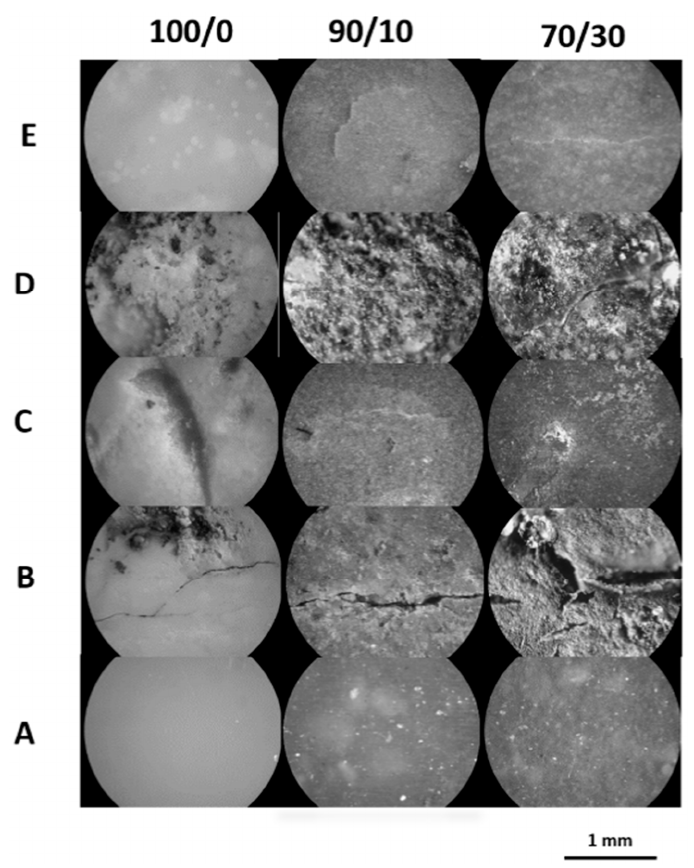
Figure 3. Photomicrographs (120x) of the pure P(3HB- co -4HB) (100/0) and P(3HB- co -4HB)/cork composites with a mass ratio of 90/10 and 70/30, respectively, before ( A ) and after 21 days of degradation in a respirometer ( B ), BIODEGMA ( C ), container ( D ) and water ( E ).